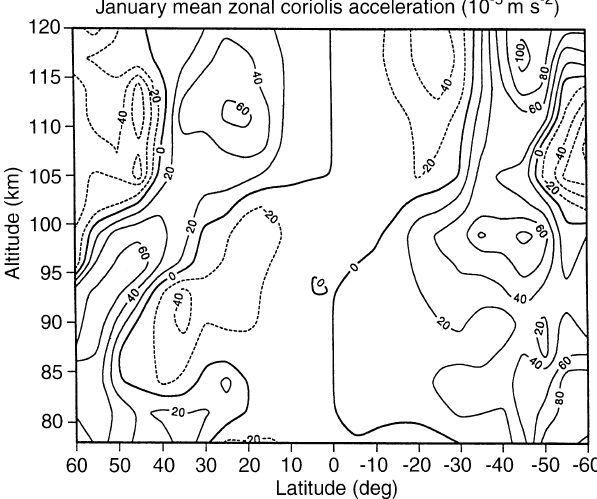
Fig. 13. Latitude-height distribution of the mean zonal Coriolis acceleration in January